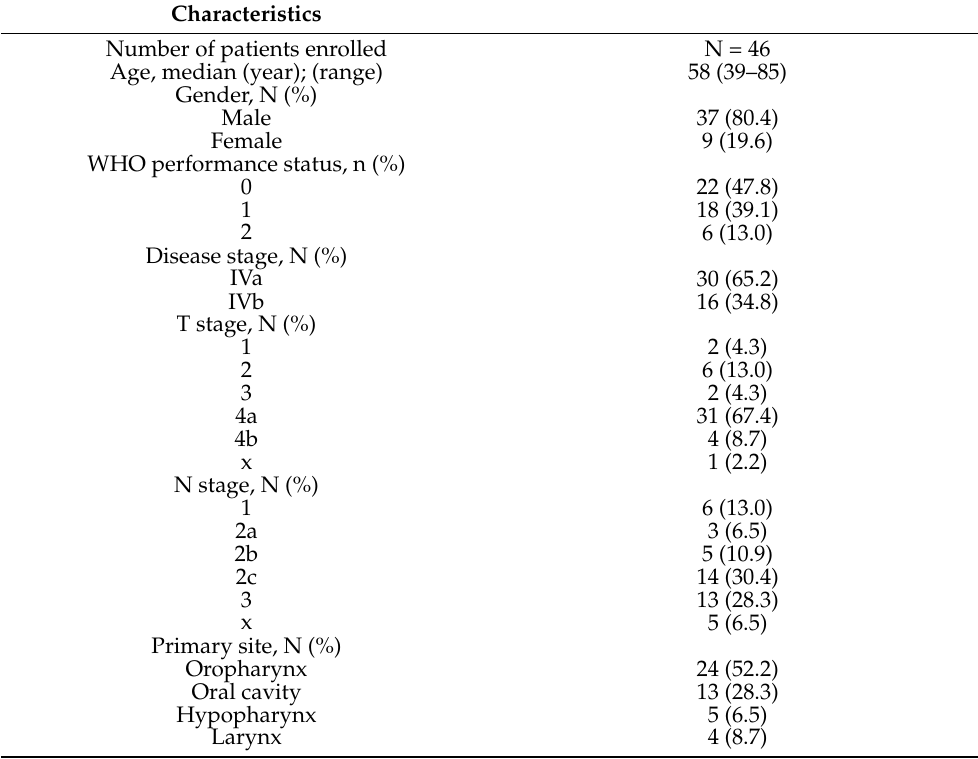
Table 1. Patient demographics and baseline characteristics of patients treated at the recommended dose of everolimus of 50 mg/week.